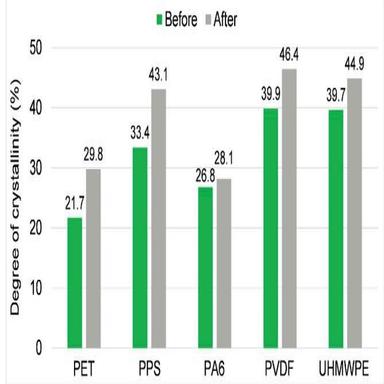
Degree of crystallinity of tested semi-crystalline materials before and after wear testing (measured by DSC).